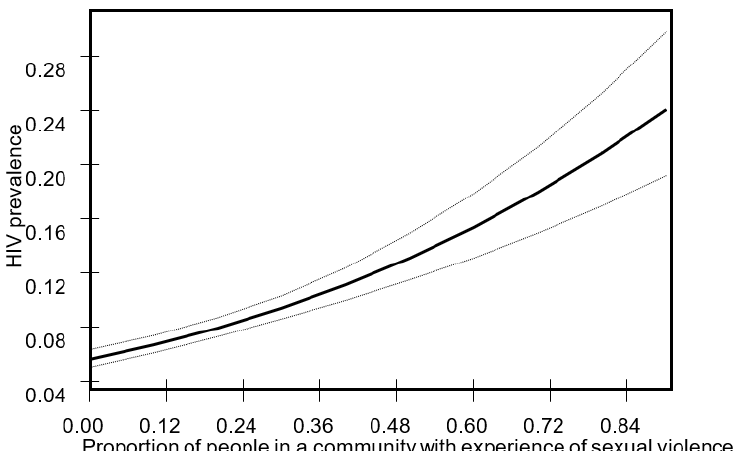
Figure 1. Increase in HIV prevalence in a community where a high proportion of people have experience of sexual violence ( n = 7784, cluster = 470) Uganda AIS, 2011. Table 4. HIV prevalence by sexual violence and community-level factors after controlling for individ- ual level effects, UAIS, 2011 ( n =